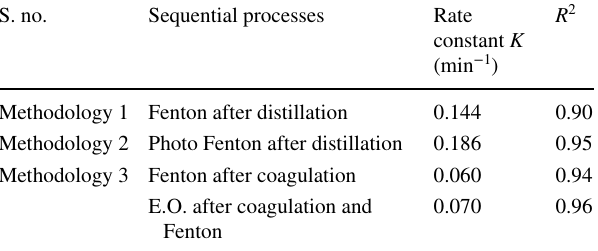
Table 2 R 2 and rate constants values of various treatment methods used for treating pesticide intermediate waster sample S.